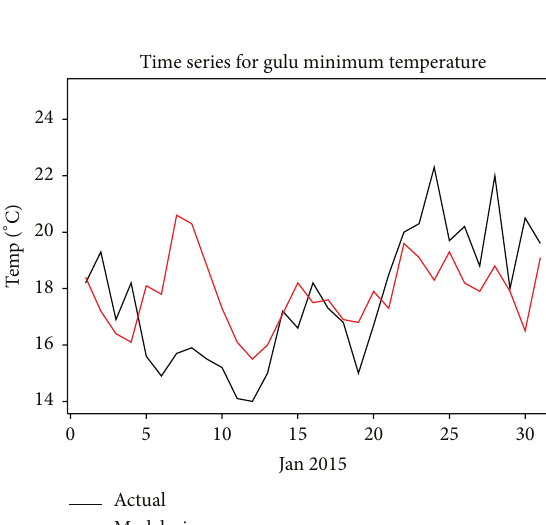
Figure 11: Gulu: max temp.